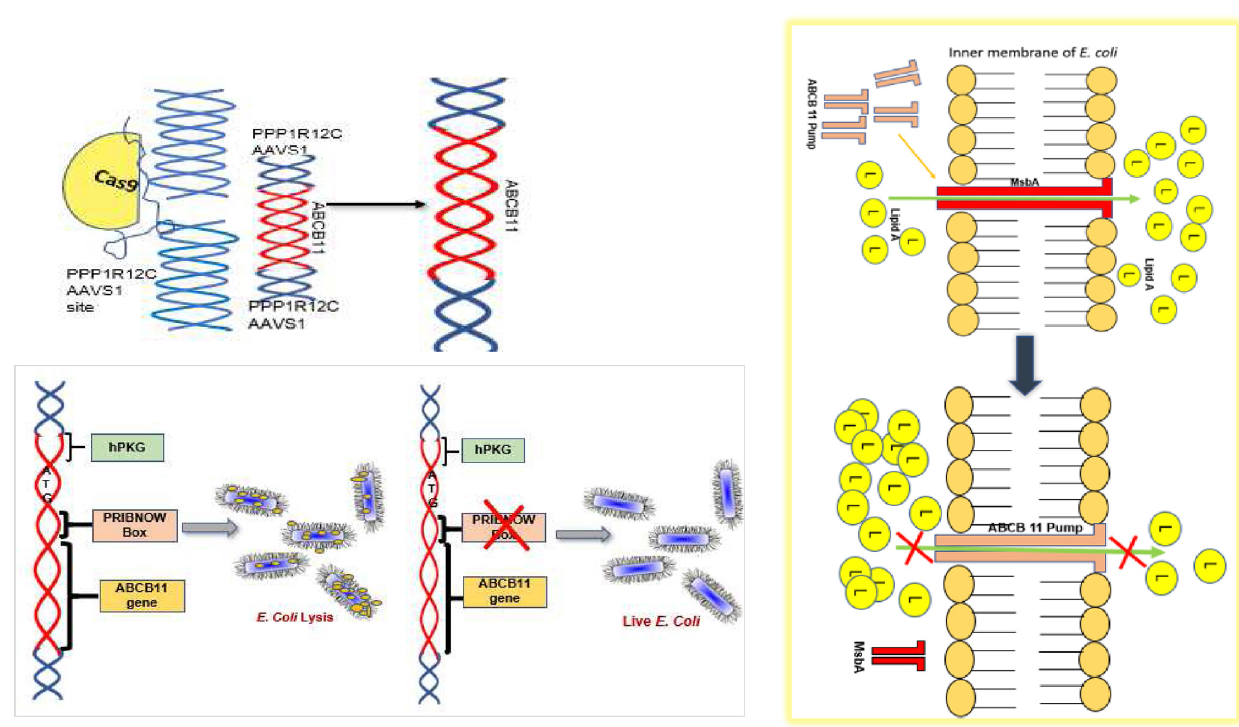
Figure 9. The ABCB11 gene (which codes the transporter of human bile salts) is targeted to AAVS1 site using a construct which has 5’ and 3’ overhangs which are homologous to the AAVS1 site. A Pribnow box was detected inside ABCB11 , which allowed the